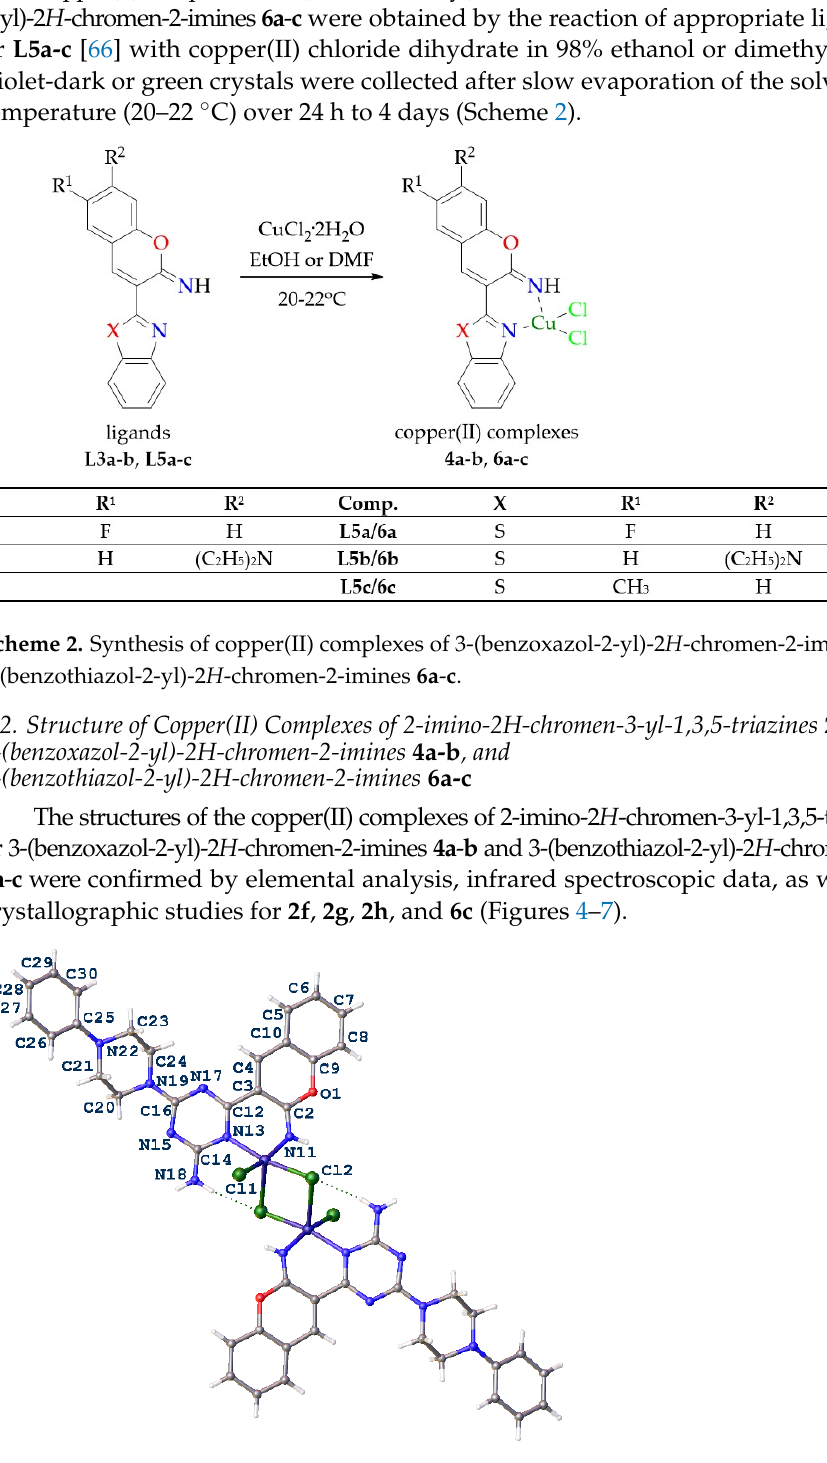
Figure 4. The dimeric molecular structure of 2f . Displacement ellipsoids are shown at the 50% probability level.